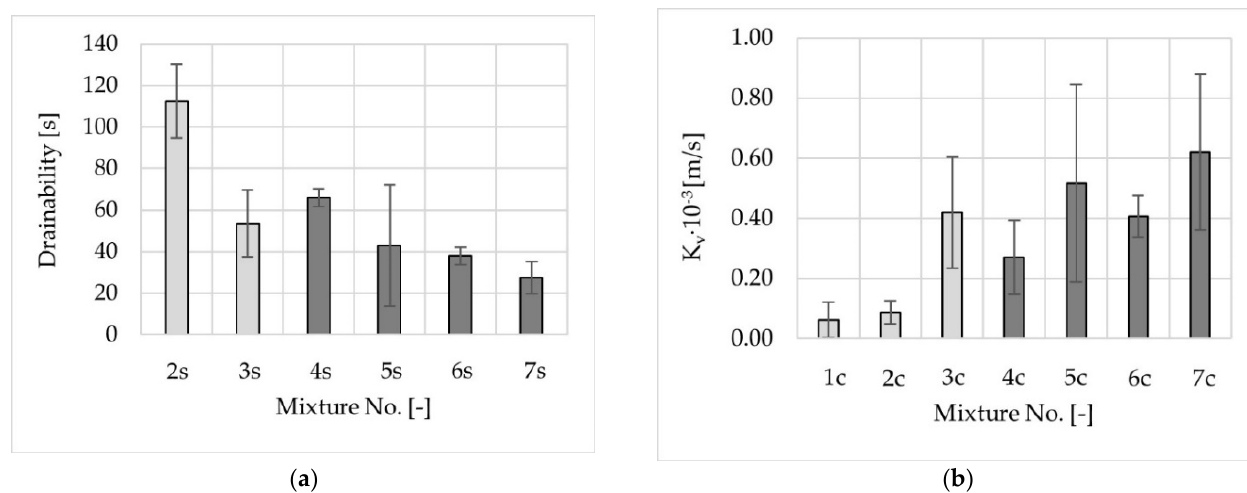
Figure 13. Water drainability of test slabs (in situ method outflow time) ( a ) and vertical water permeability of cylindrical specimens ( b ) of poroelastic mixtures.